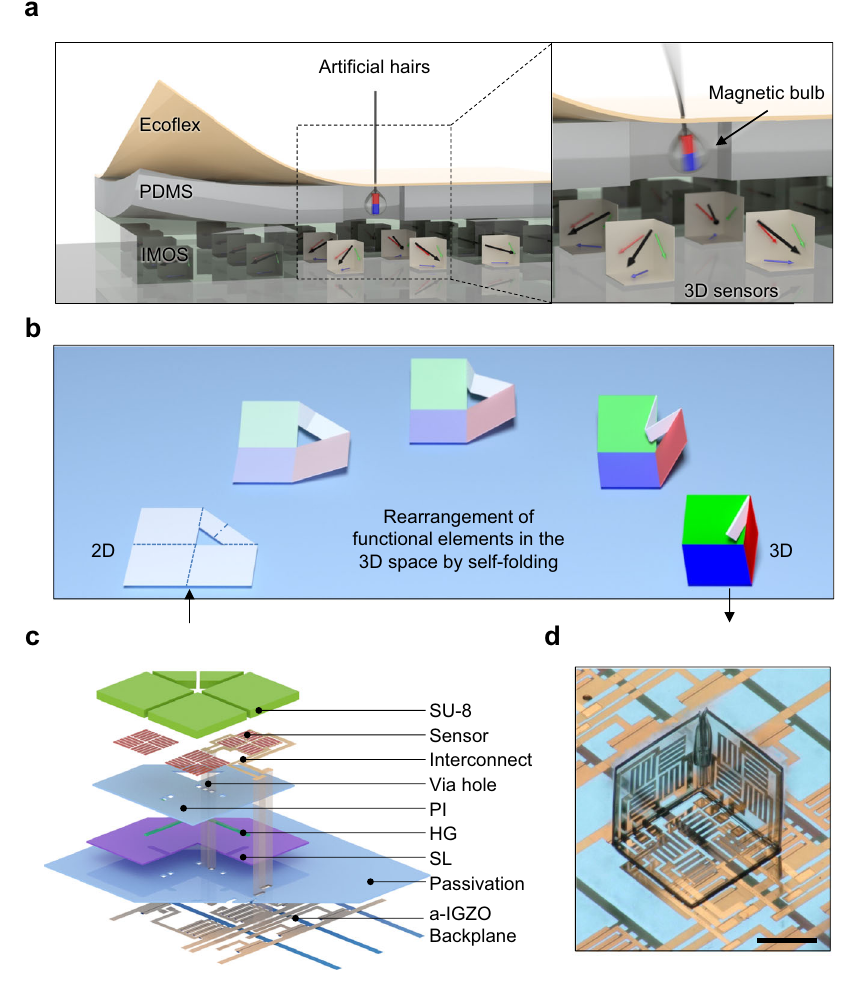
Fig. 1 Concept and structure of the IMOS device. a Vision of the IMOS devices for e-skin application. Conceptual images illustrating the application of the IMOS device in the hair-inspired sensation system for mechanoreception. The stray fi eld strength and direction of the hair-attached small magnets would be changed due to bending of the hair, which is detectable by the IMOS device. b Deterministic self-folding process. Illustration of the self-folding micro- origami process. Orthogonal folding is obtained due to the rational design of the layout and the hinges. c Layout design of the self-foldable platform. Exploded schematic of the layout for the self-foldable polymeric platform with embedded electronics and integrated active matrix driving circuitry. The embedded electronics and the a-IGZO active matrix backplane are interconnected through via holes. d One pixel in the 3D sensor. Image of a single pixel which is composed of a self-folded polymer cube containing three sensors located on the orthogonal planes. The side length of the cube is 400 µ m. Scale bar, 200